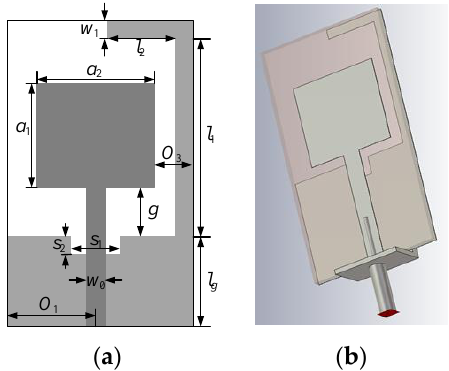
Figure 5. The UWB monopole antenna [19]: ( a ) Geometrical details of the radiator and ground plane; ( b ) 3D visualization of the antenna with the SMA connector in CST (The design is electrically small. In order to ensure the reliability of the simulation results, the electromagnetic (EM) model is simulated with an SMA connector attached).